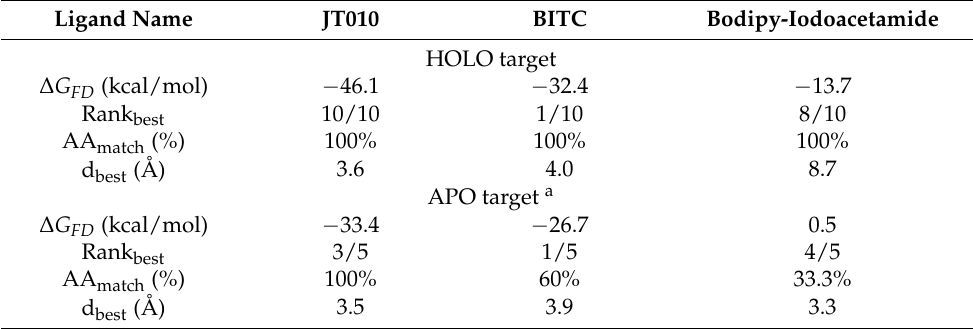
Table 2. Non-covalent docking calculations performed by FITTED.